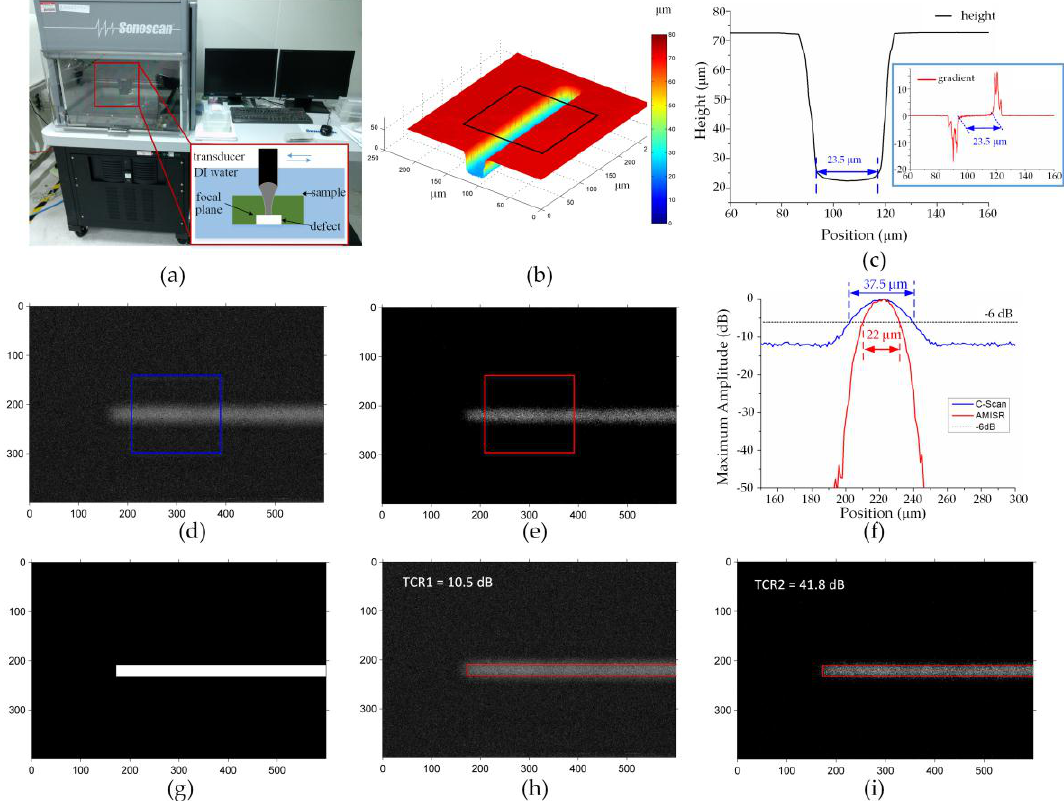
Figure 4. Results of the single groove (unit in µ m): ( a ) Schematic diagram of AMI; ( b ) The topography of the groove; ( c ) Average profile of the groove; ( d ) Original C-scan image; ( e ) The reconstructed image formed by AMISR; ( f ) Average values of the regions indicated in (d) and (e); ( g ) The cross section of the groove; ( h ) The original C-scan image superimposed with the mask; ( i ) The reconstructed image superimposed with the mask.